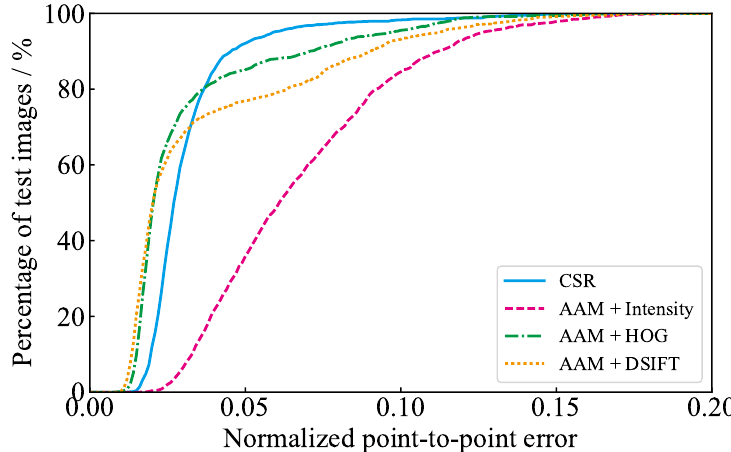
Figure 5. The percentage of test images satisfying a given Normalized Point to Point Error (NPPE) for each method.